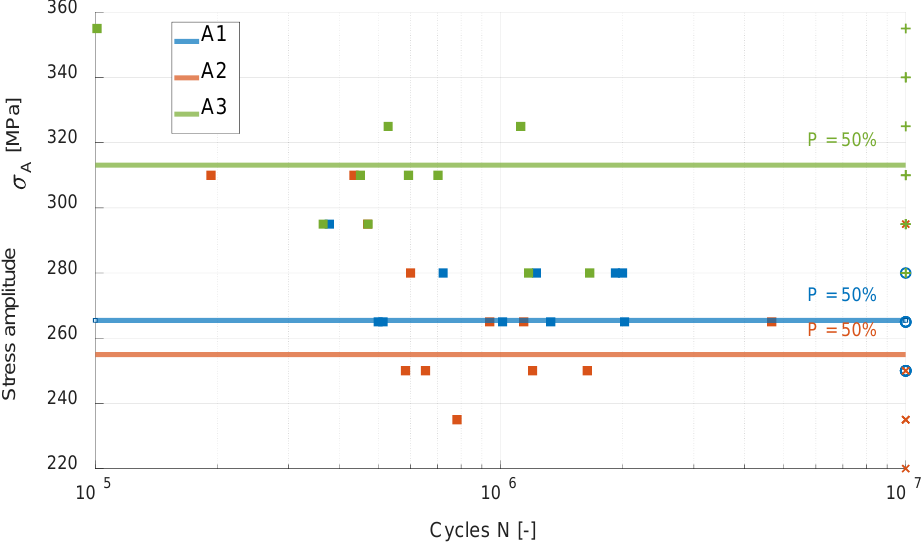
Figure 4. Woehler diagram of rotating bending fatigue testing of alloys A1, A2 (0.33 wt.% Al) and A3 (0.18 wt.% Al).